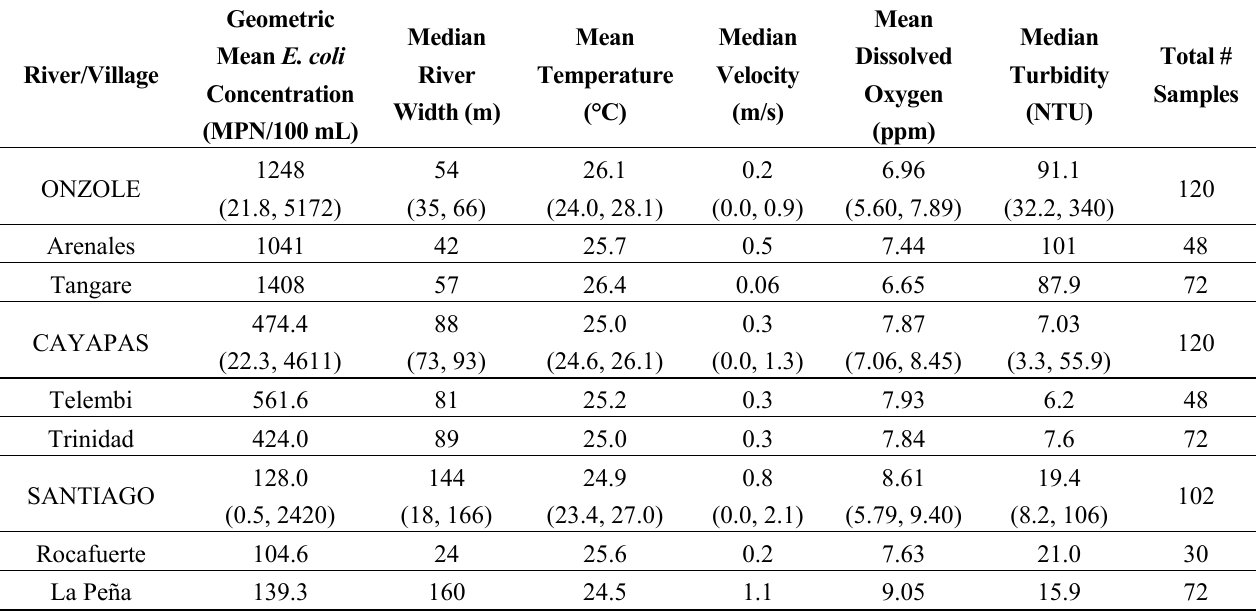
Table 1. Summary of water quality river parameters by river and